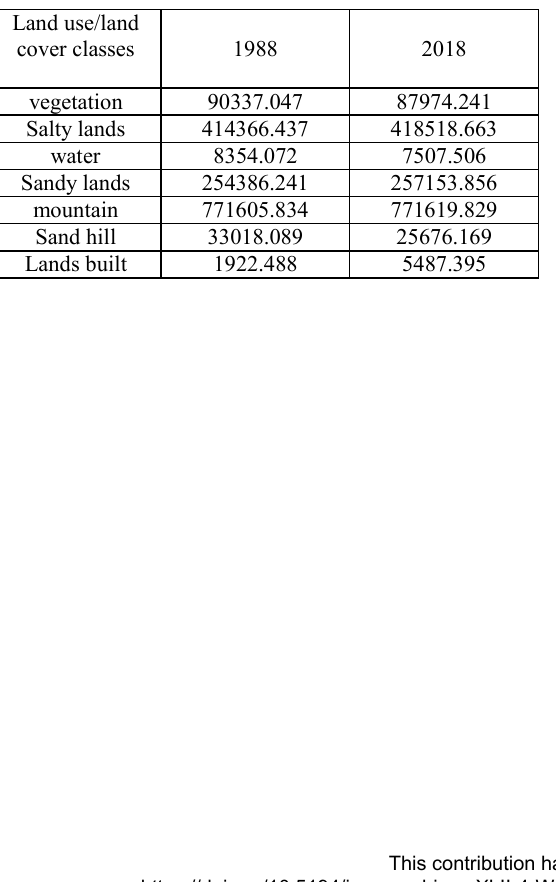
Figure 2. Land use/land cover in 1988, 2018 Table 1. Land use/land cover pattern during different years (Area in